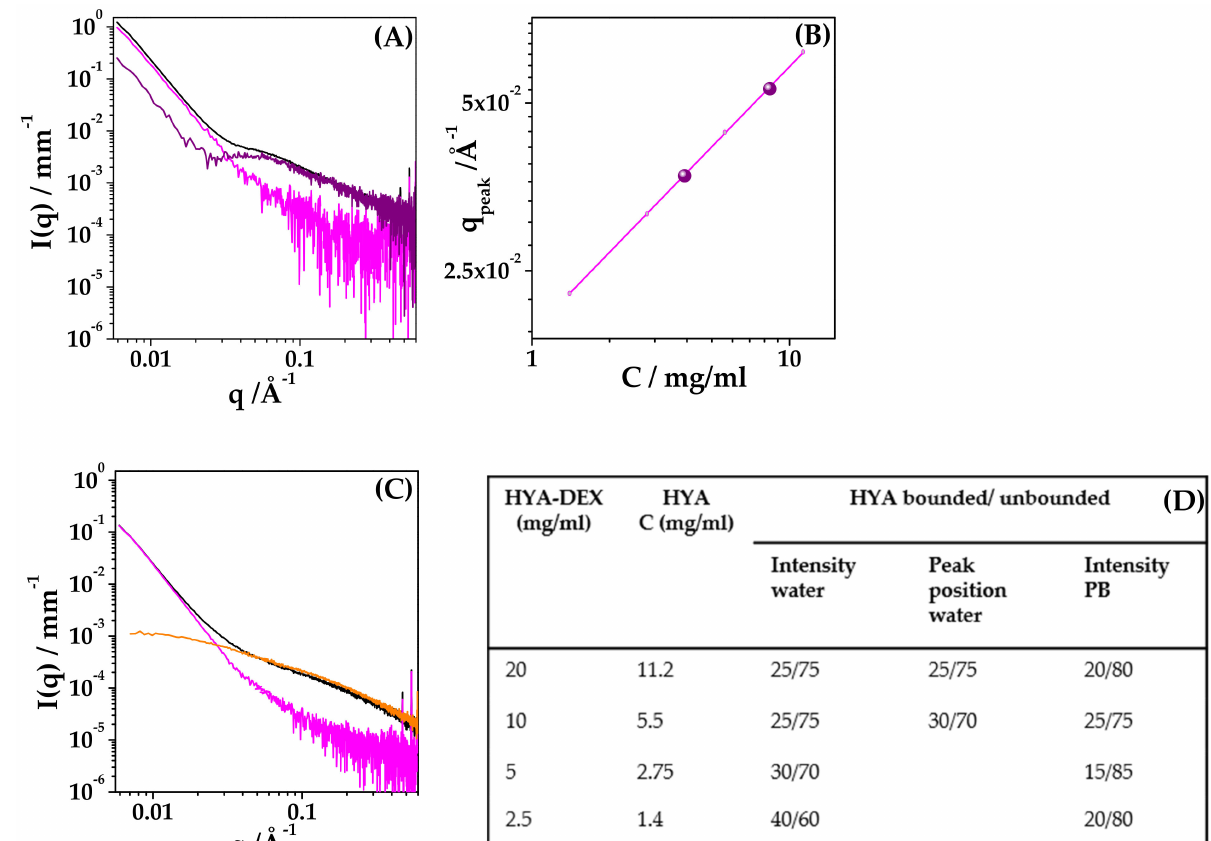
Figure 8. Evaluation of bound/unbound HYA. ( A ) SAXS spectra of HYA–DEX nanoparticles at 20 mg/mL in water (black), experimental intensity contribution of nanoparticles (magenta), difference between black and magenta signals (purple). ( B ) Peak position (q peak ) for 10 mg/mL and 20 mg/mL samples (purple dots). The magenta line represents the scaling behaviour of HYA. ( C ) SAXS spectra of HYA–DEX nanoparticles at 20 mg/mL in PB (black), intensity contribution of HYA at the same nominal concentration, 11.2 mg/mL (orange), difference between black and 0.8 × orange signals (magenta) to obtain the contribution of nanoparticles in PB. ( D ) (Table) Fraction of bound/unbound HYA as calculated by the analysis of the intensity contribution or by the q peak